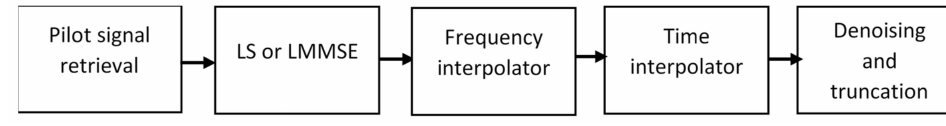
Figure 18. Pilot-based channel estimation